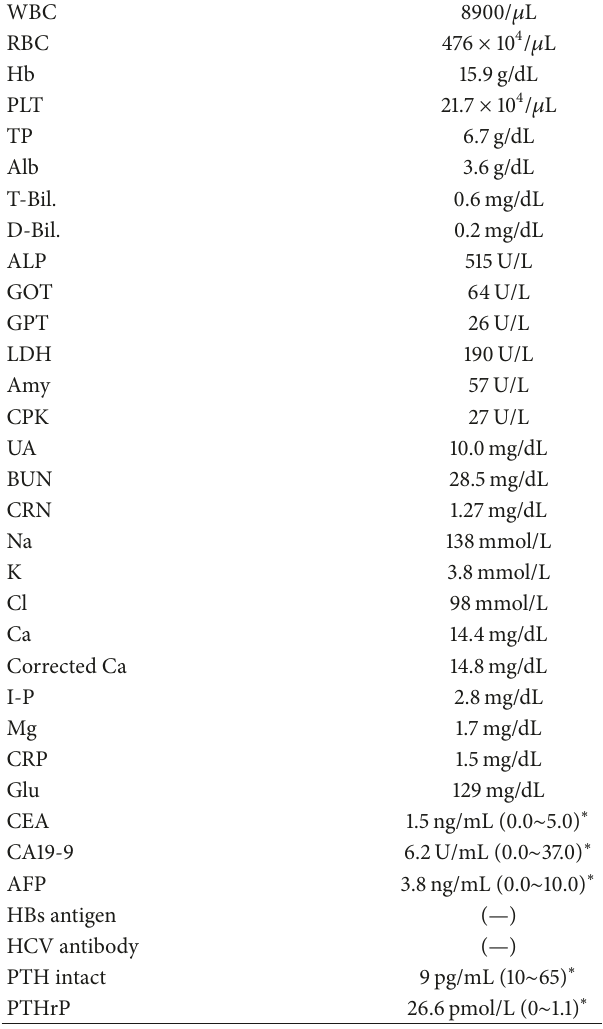
Table 1: Laboratory data on admission.